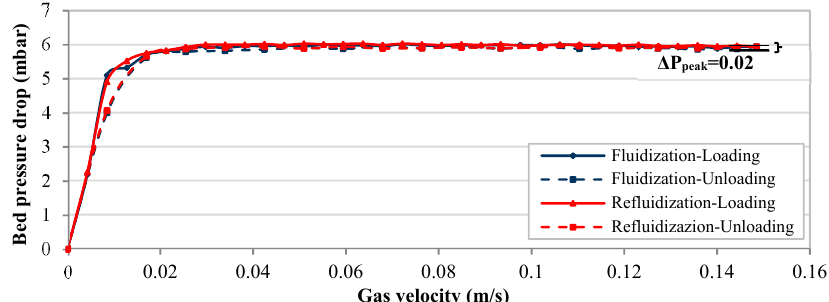
Figure 7. Fluidization and re-fluidization behaviors (after compression at 40 kPa, intermediate pressure) for fine powder (CALCIT MVT 100).